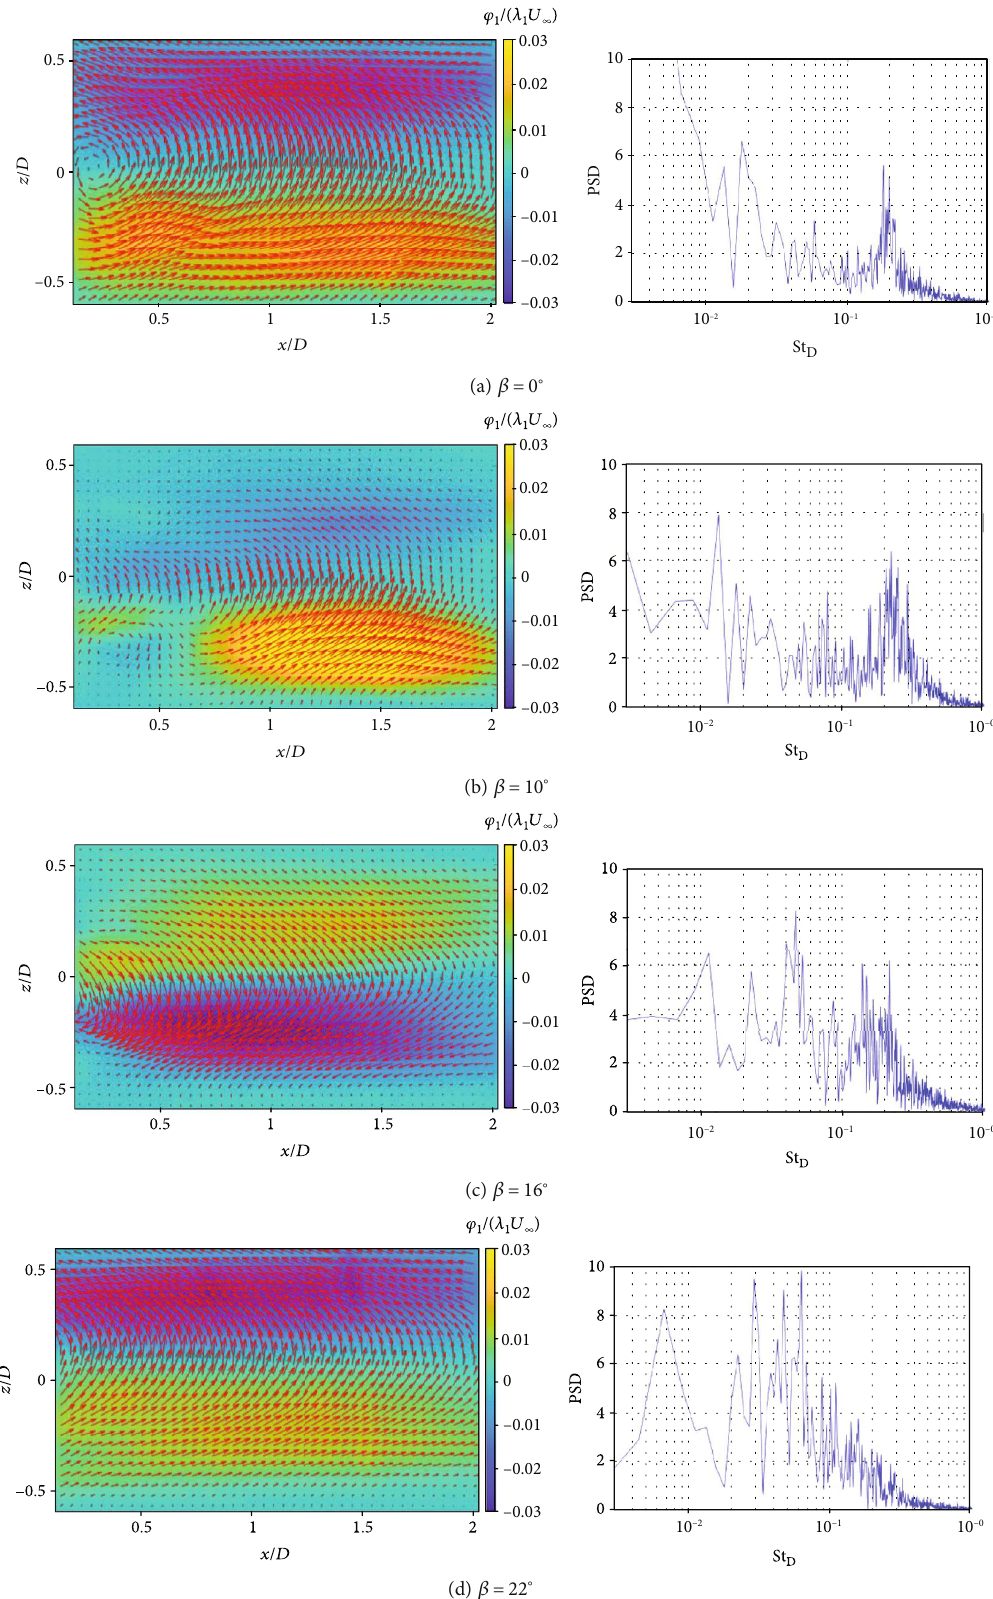
Figure 16: Spatial distribution of the fi rst POD mode at (a) β = 0 ° , (b) β = 10 ° , (c) β = 16 ° , and (d) β = 22 °